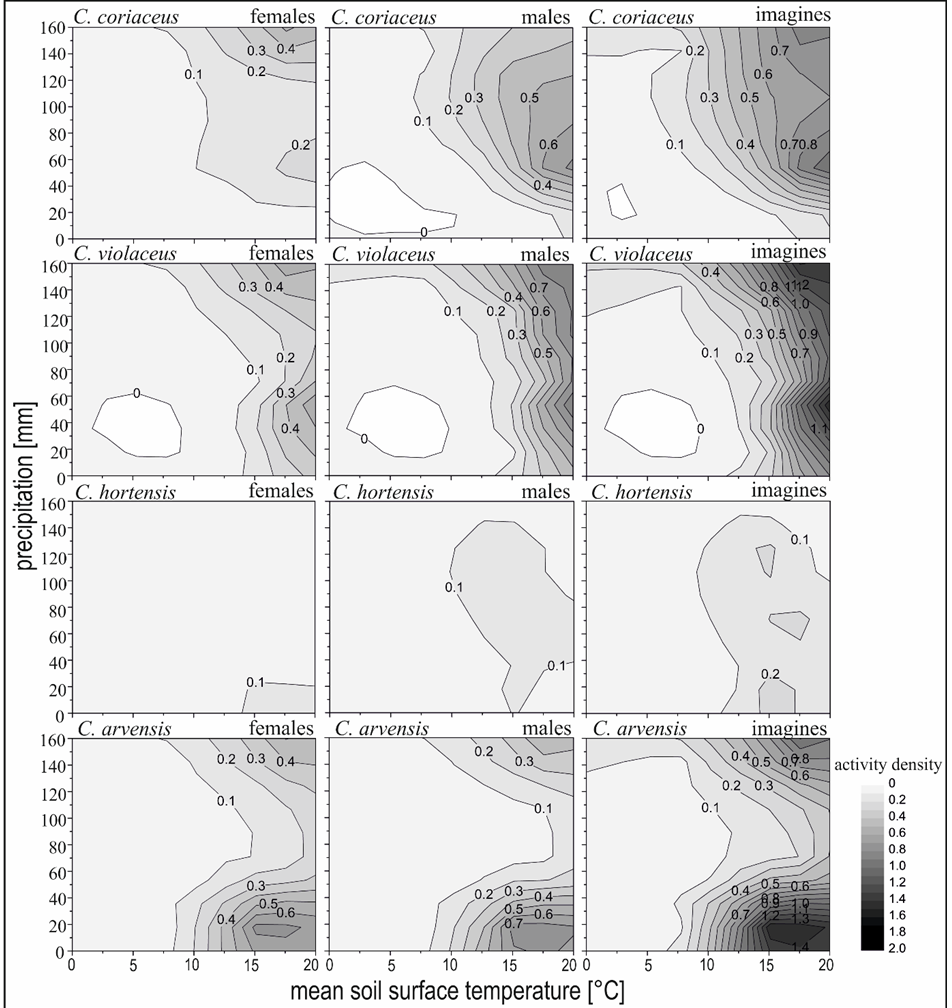
Figure 2. Contour line graphs showing the linear interpolation of activity densities (m 2 ) of C. coriaceus , C. violaceus , C. hortensis and C. arvensis relative to the mean soil surface temperature (°C) and the total precipitation (mm) based on monthly sample periods (see also Table 1).